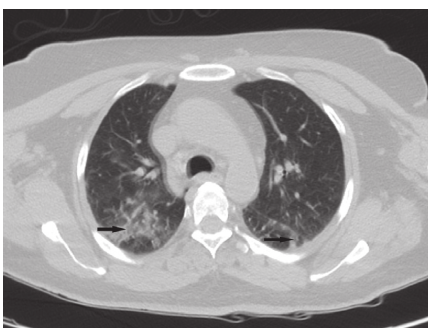
Figure 2: Noncontrast thoracic CT scan (axial view) showing bilateral lung infiltrations (black